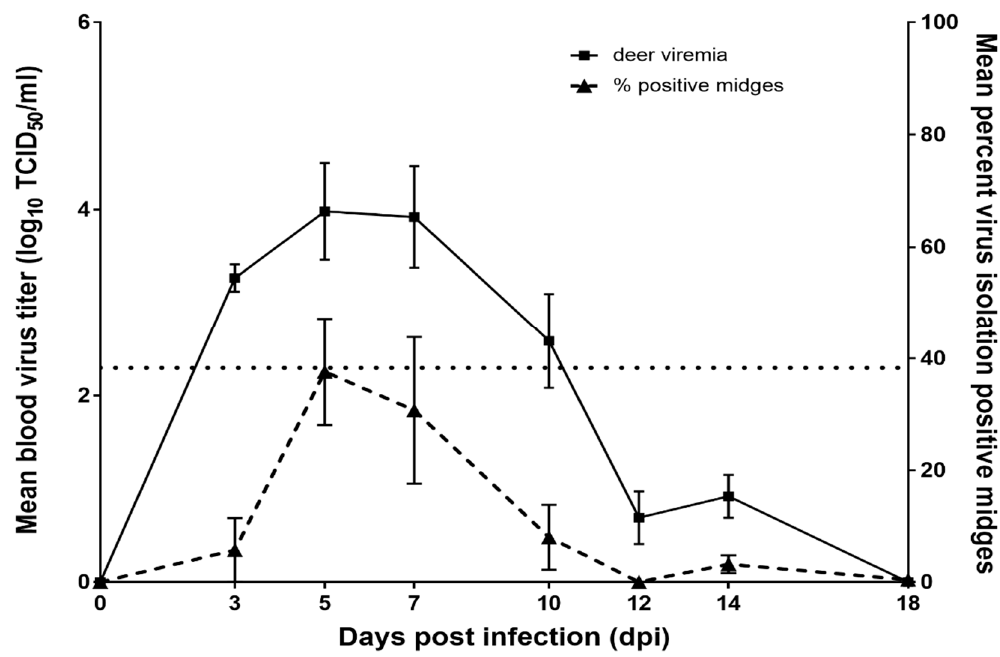
Figure 2. Mean epizootic hemorrhagic disease virus serotype 2 titer of viremic deer and proportion of infected midges determined by pooling data from all 5 deer for each time point. Standard error bars are shown for both mean deer viremia and midge infection prevalence. A lack of standard error bars indicates no variation in values observed. The dotted line at 2.3 on the primary y-axis indicates the limit of detection for blood virus titer (10 2.3 tissue culture infective dose (TCID) 50 /mL).